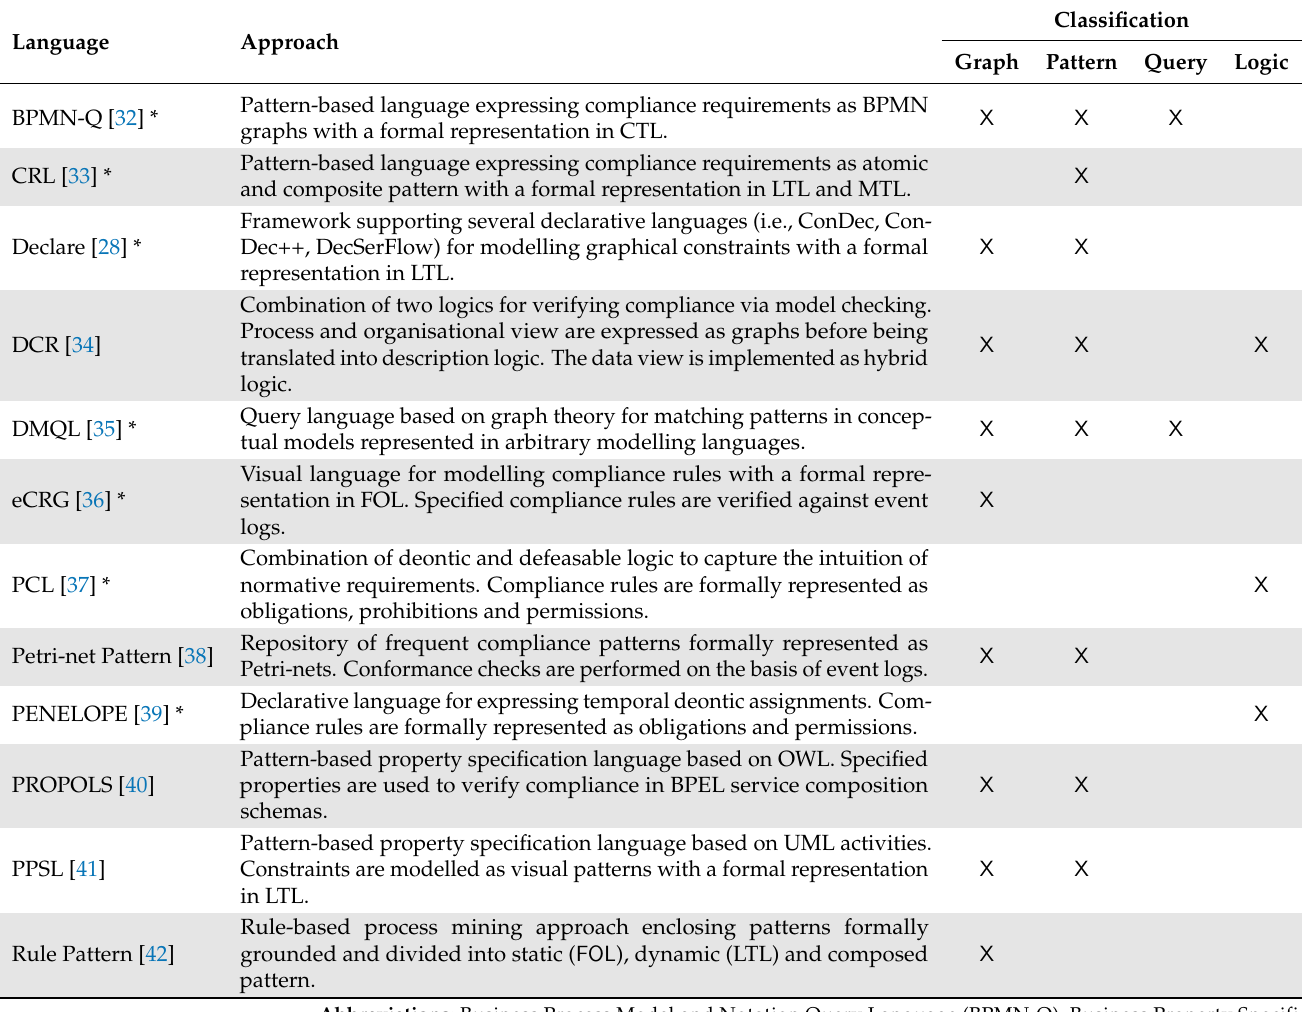
Table 1. List of selected